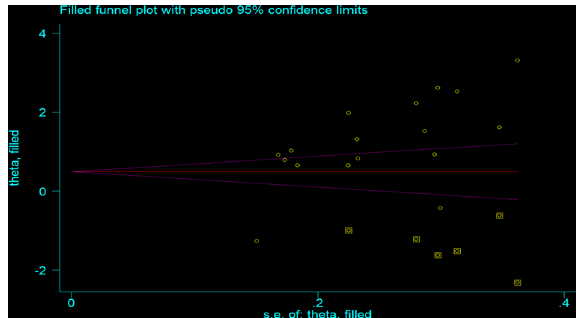
Figure 7. The funnel plot of a simulated meta-analysis containing 17